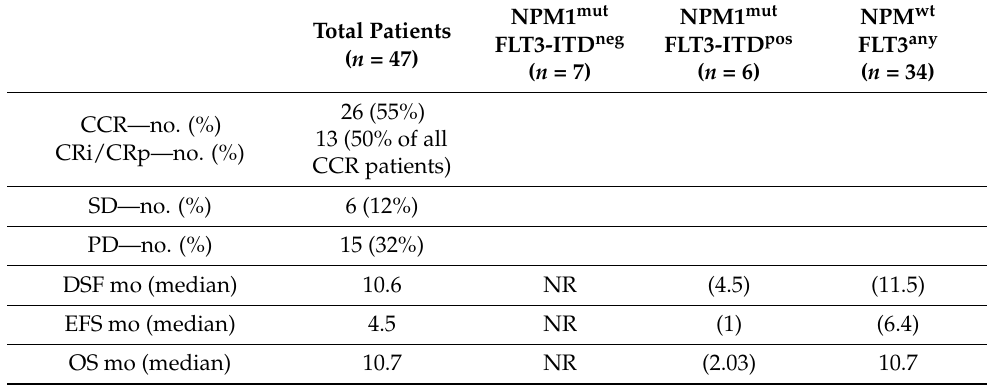
Figure 3. Kaplan-Meier plots representing disease-free survival for the shole study cohort ( A ), by HSCT bridging ( B ) and by ELN 2017 risk group ( C ). Despite not reaching statistical significance due to the small sample size involved, a protective effect for HSCT can be desumed from ( B ). Table 2.